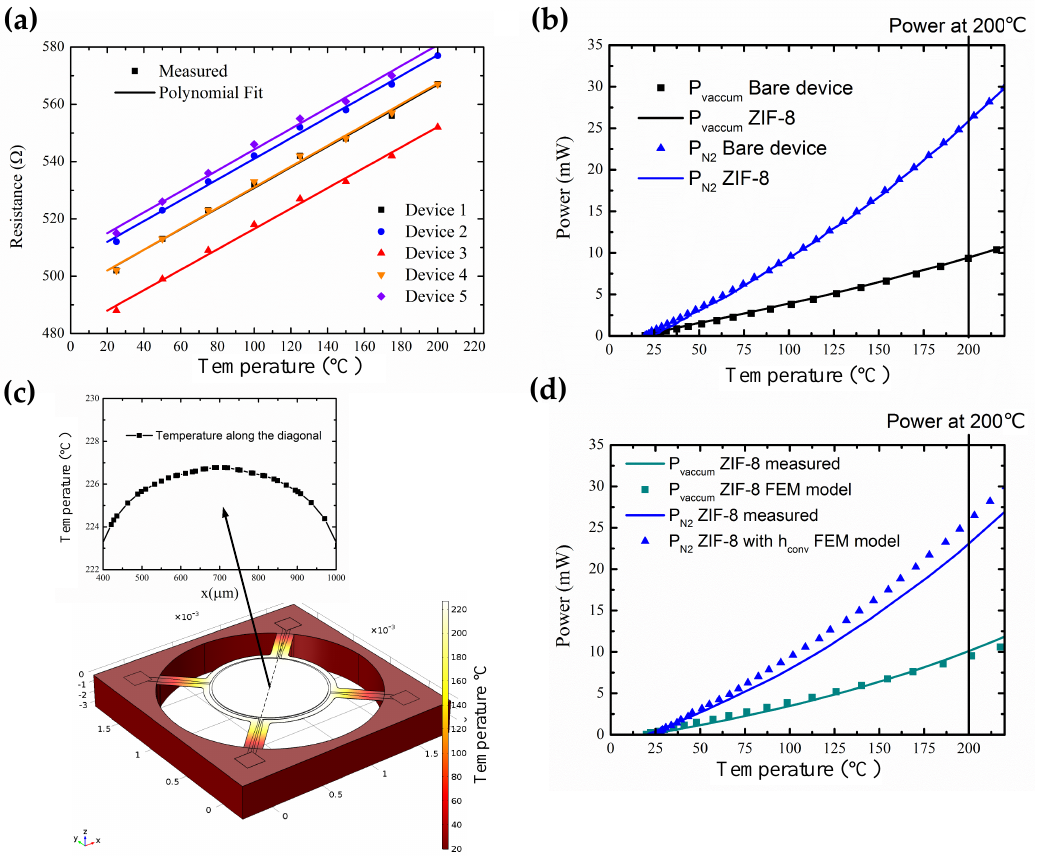
Figure 5. ( a ) Power consumption in bare device. ( b ) Comparison between power consumption in bare device and ZIF-8 coated device in vacuum and nitrogen. ( c ) Finite Element Method (FEM) thermal analysis of ZIF-8 coated device. ( d ) Comparison between power consumption of ZIF-8 coated device and FEM